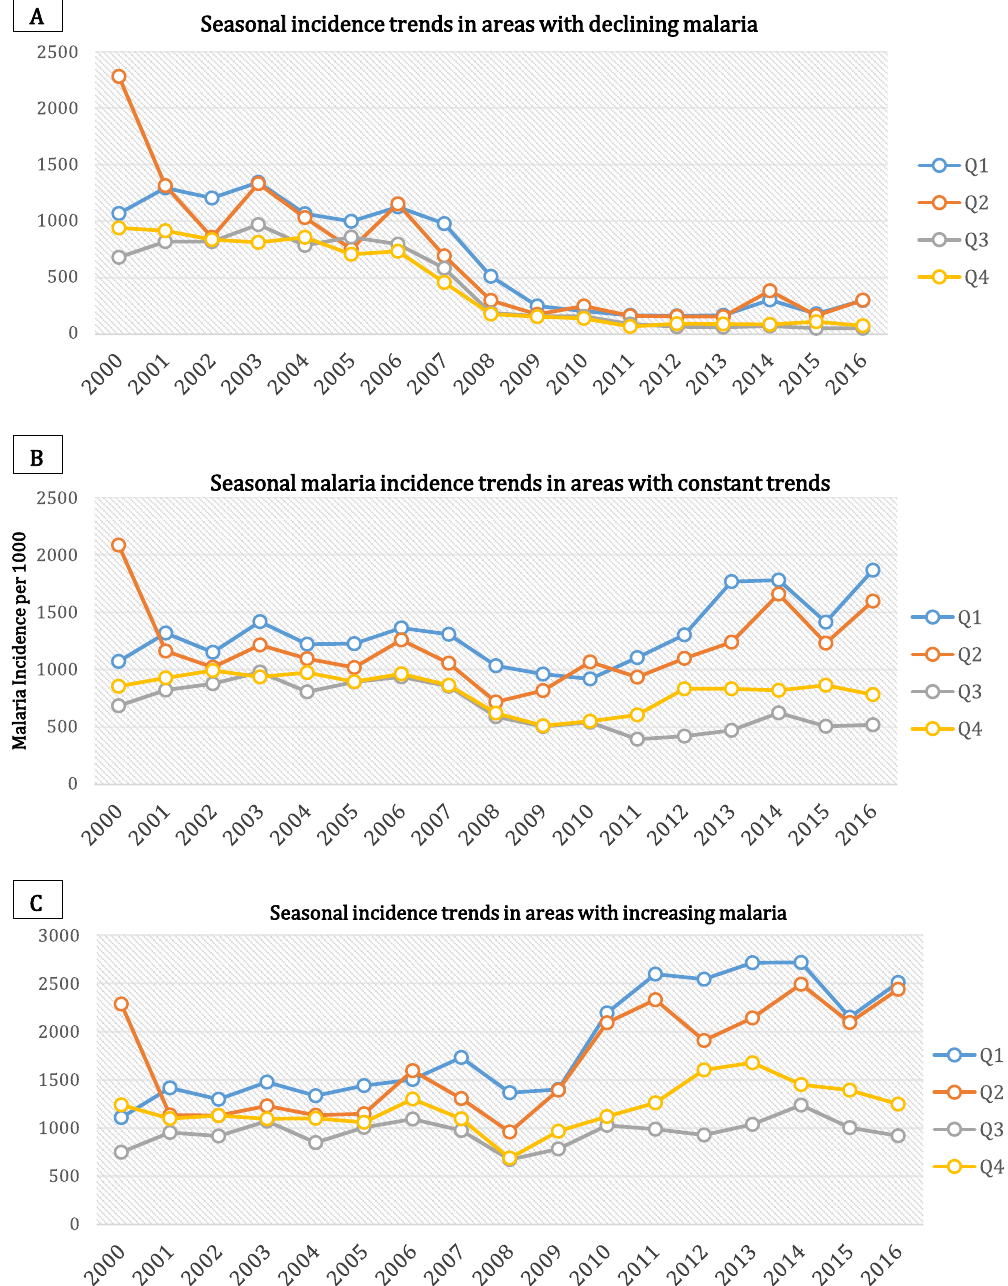
Figure 4. Seasonality of malaria in areas of decline, increase, or constant